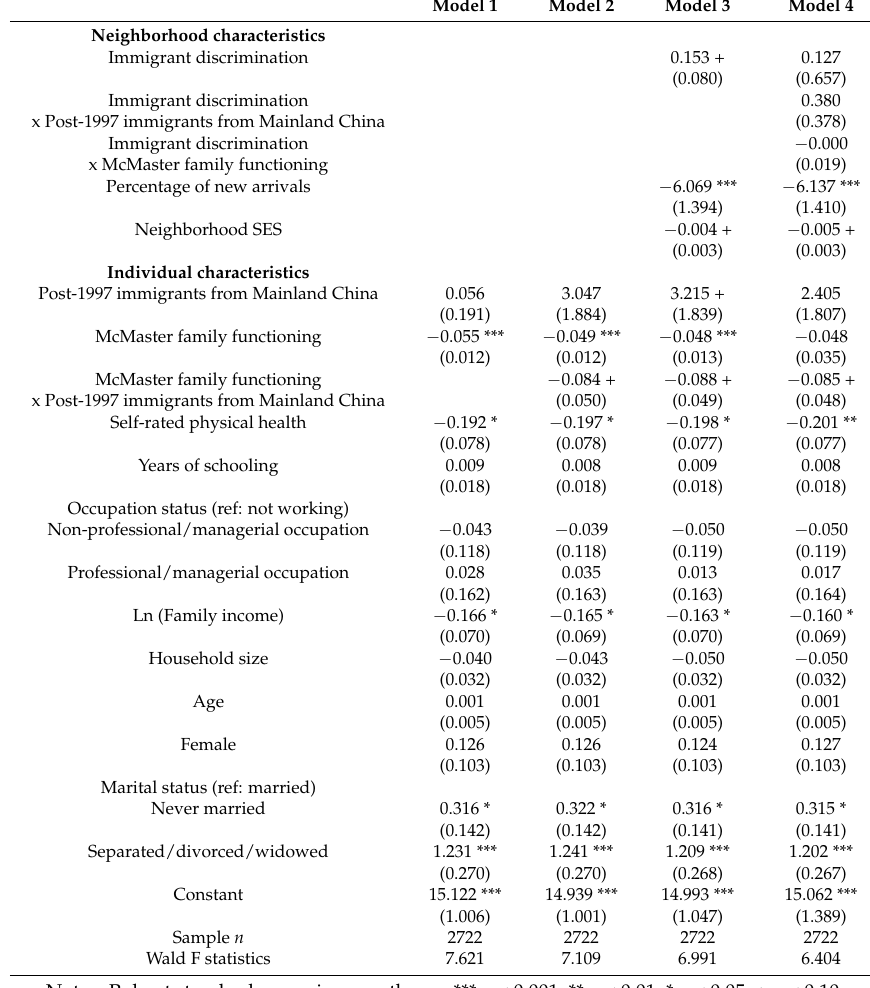
Table 3. OLS Estimating Association between Immigrant Discrimination and HSCL Psychological Distress among Private/Subsided Housing Residents with